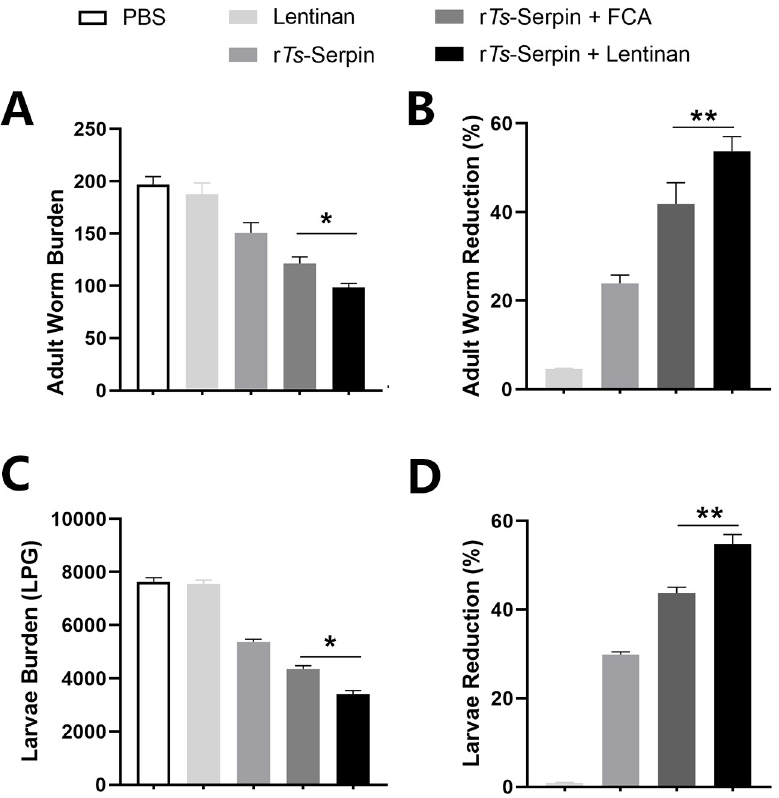
Fig 1. Protective immunity induced by immunizing mice with lentinan against T . spiralis . The number of adults recovered from intestines (A) and muscle larvae (ML) per gram (LPG) in skeletal muscles (B) from mouse groups immunized subcutaneously with PBS (PBS), r Ts -Serpin (r Ts -Serpin), r Ts -Serpin emulsified with Freund’s adjuvants (r Ts -Serpin+FCA, and r Ts -Serpin emulsified with lentinan (r Ts -Serpin+lentinan), after challenge with 500 ML of T . spiralis . The adult worms (C) and muscle larvae (D) reduction rates were analyzed based on the the mean number of adult worms or the recovered muscle larvae per gram (LPG) of muscle from vaccinated groups compared with PBS group. Results are expressed as the mean ± SD of 10 mice per group. The data shown are representative of three independent experiments. � p < 0.05, �� p < 0.01, vs the as indicated by the line (Tukey multiple comparison following